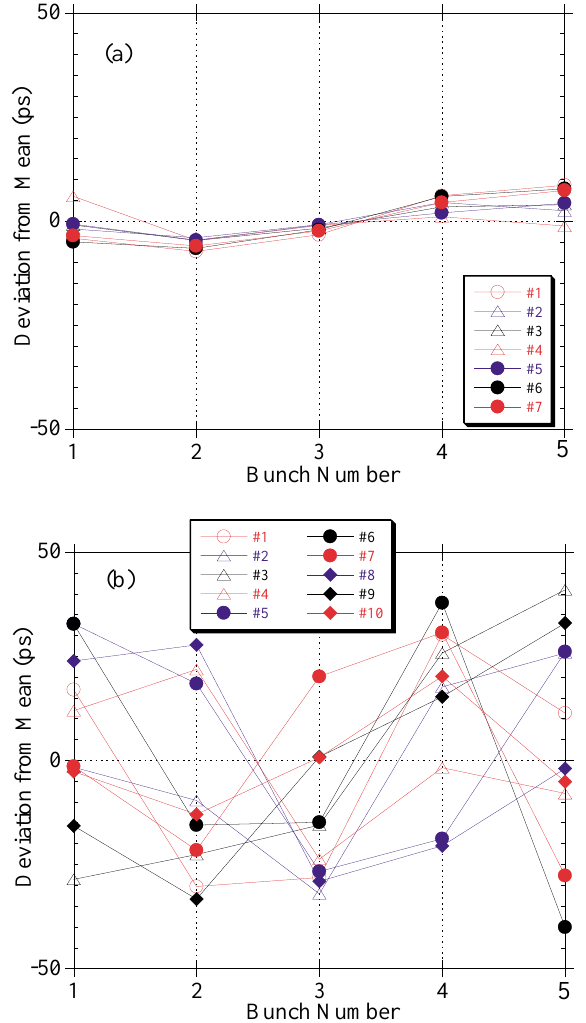
FIG. 35. (Color) A plot of the CLEO luminosity as a function of time. The dip in the luminosity occurred when the longitudinal feedback system was turned off and the beams were